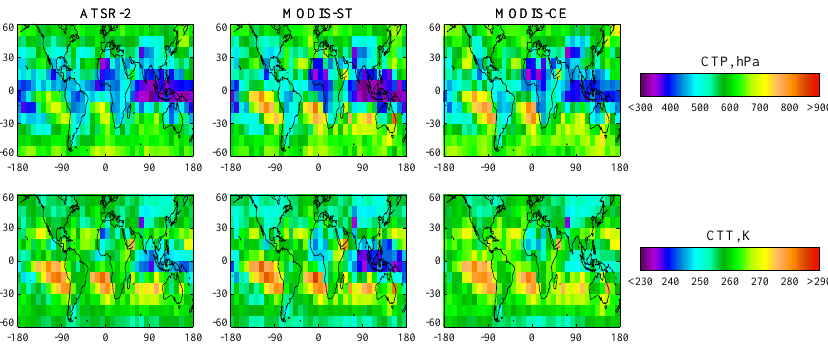
Fig. 15. Comparison between annual mean (colocated data for the year 2001) cloud-top pressure (top) and cloud-top temperature (bottom) derived from ATSR-2 and MODIS-Terra. The left column shows data from ATSR-2, the centre column MODIS-ST, and the right column MODIS-CE.